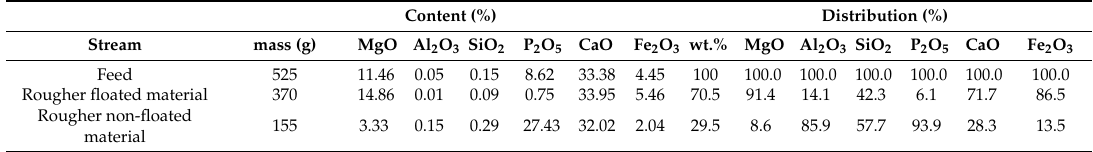
Table 6. Results of the direct flotation tests with one cleaning stage.